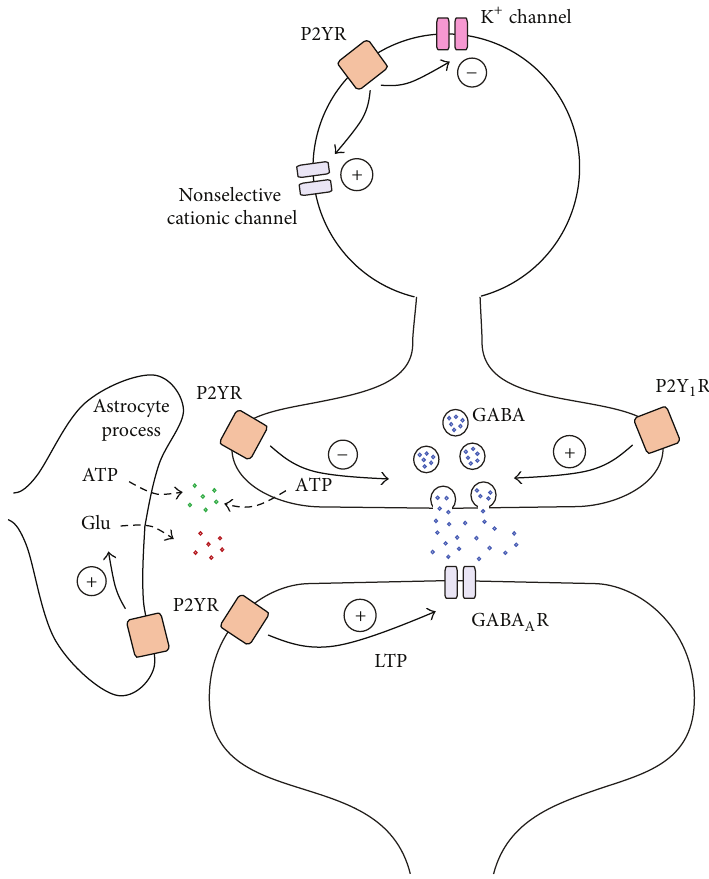
Figure 2: Modulation of inhibitory synaptic transmission by P2Y receptors in the CNS. The cartoon shows an idealized inhibitory (GABAergic) synapse between an inhibitory interneuron and an excitatory principal cell. The effects of P2Y receptors have been described in different brain areas. For more details see text. GABA A R, GABA A receptor; Glu, glutamate; LTP, long-term potentiation; P2YR, P2Y receptor; P2Y 1 R, P2Y 1